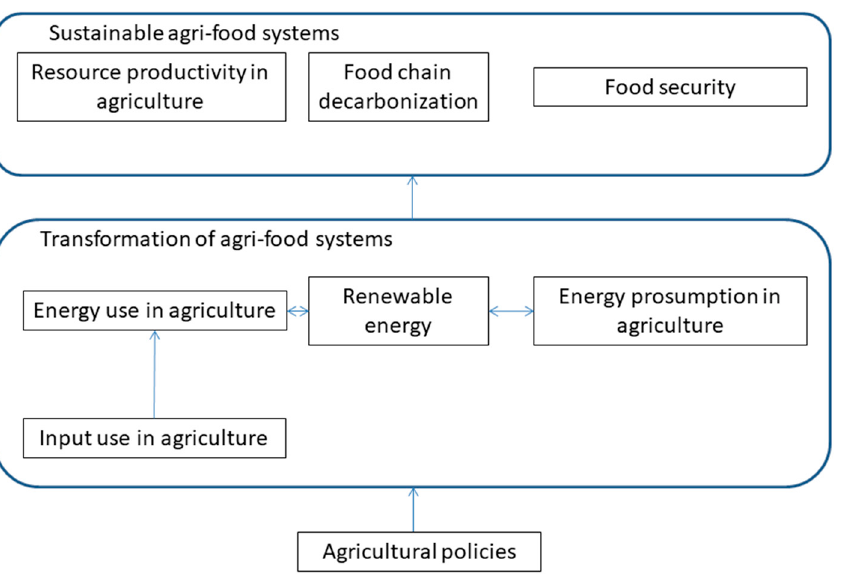
Figure 1. The role of renewables in the transformation of agri-food systems. Source: created by the authors.